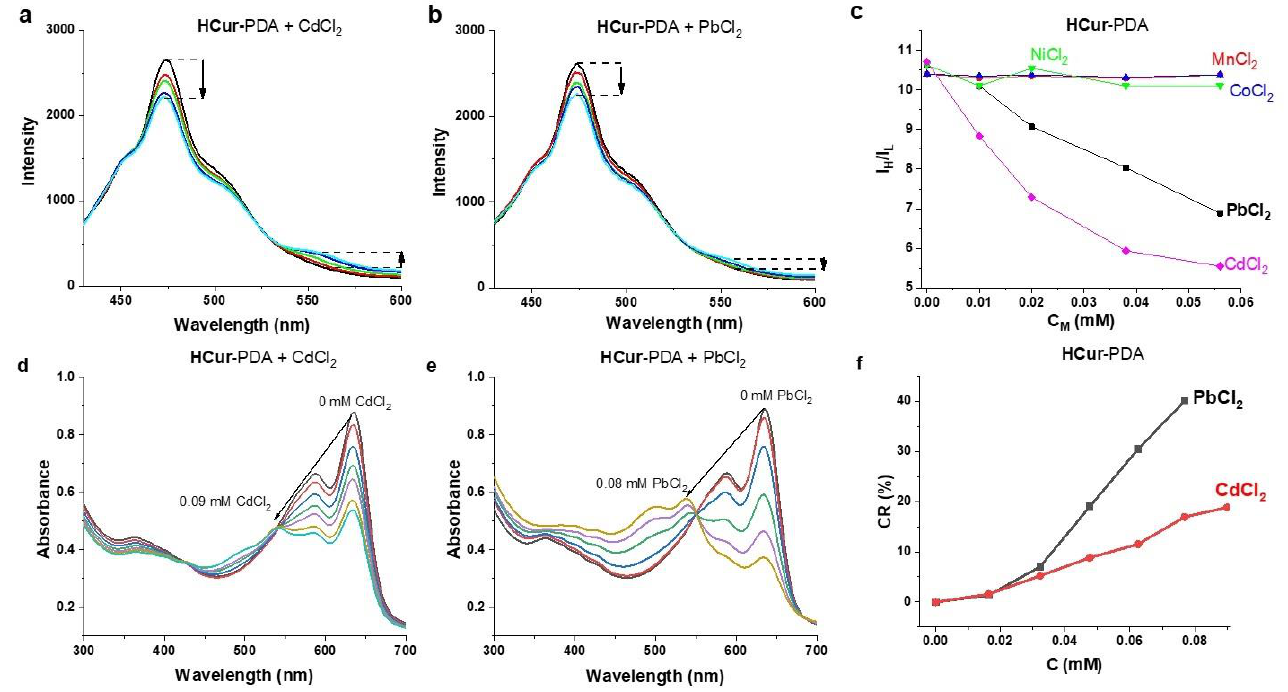
Figure 5. ( a , b ) Luminescence spectra of HCur -PDA at the concentration of CdCl 2 and PbCl 2 varied from 0 to 0.058 mM (pH = 7.5). ( c ) I H /I L of HCur -PDA vs concentration of d-metal cations (pH = 7.5): CdCl 2 ; PbCl 2 ; NiCl 2 ; MnCl 2 ; CoCl 2 . ( d , e ) UV-vis spectra of HCur -PDA at pH = 7.5 and different concentration of CdCl 2 ( d ) and PbCl 2 ( e ). ( f ) Colorimetric response (CR%) of HCur -PDA to CdCl 2 and PbCl 2 .